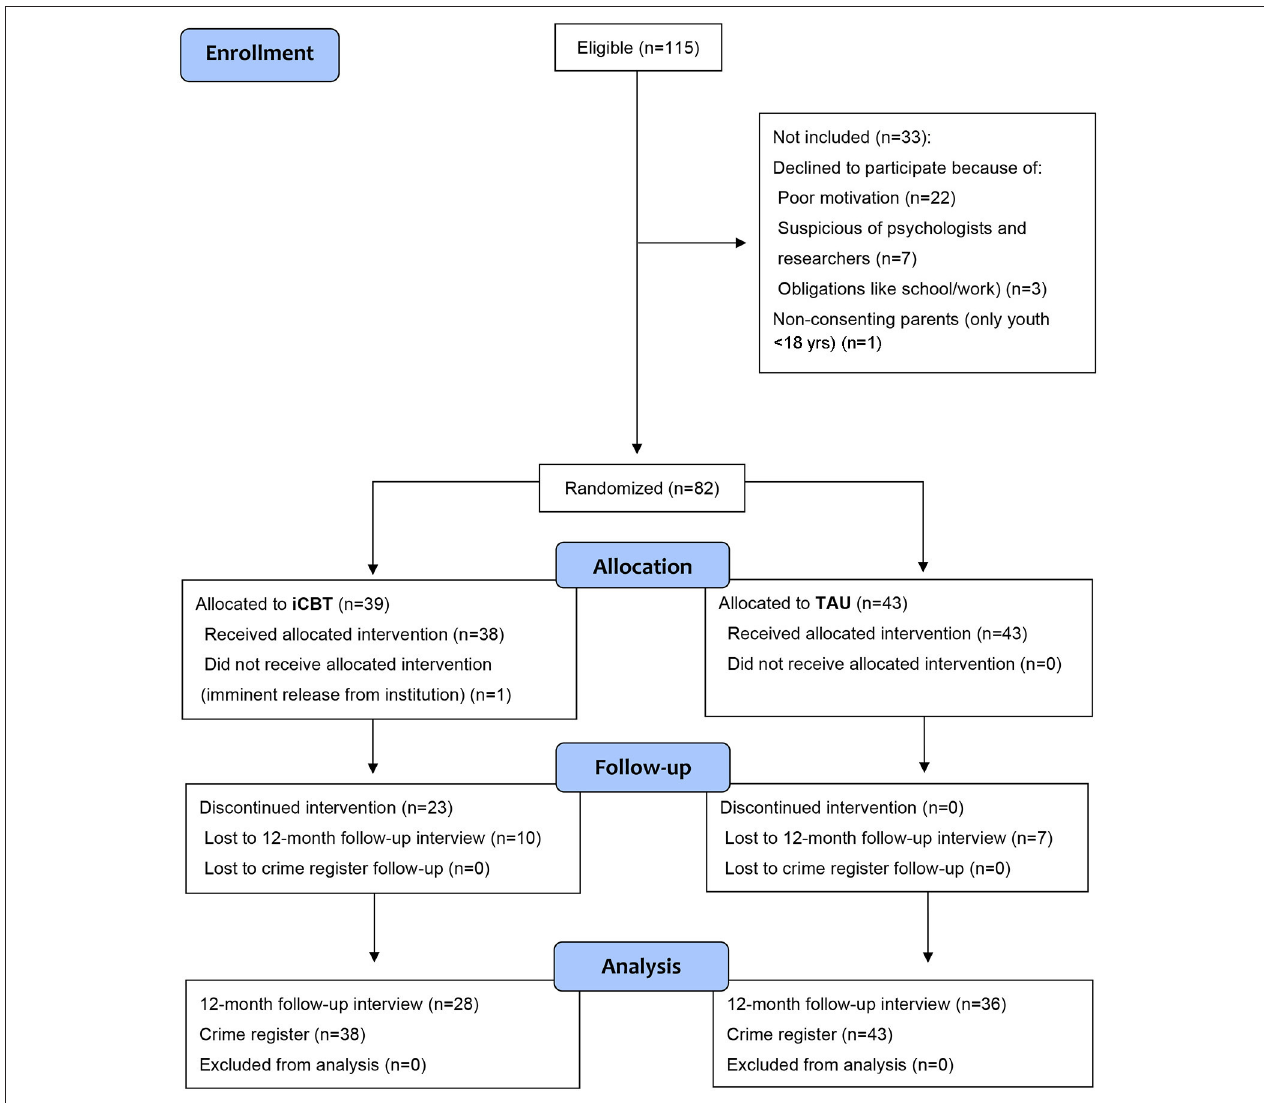
FIGURE 1 | Flowchart of a randomized controlled trial (RCT) comparing an individualized cognitive-behavioral intervention (iCBT) plus group-based treatment-as-usual (TAU) with TAU-only among serious, young male violent